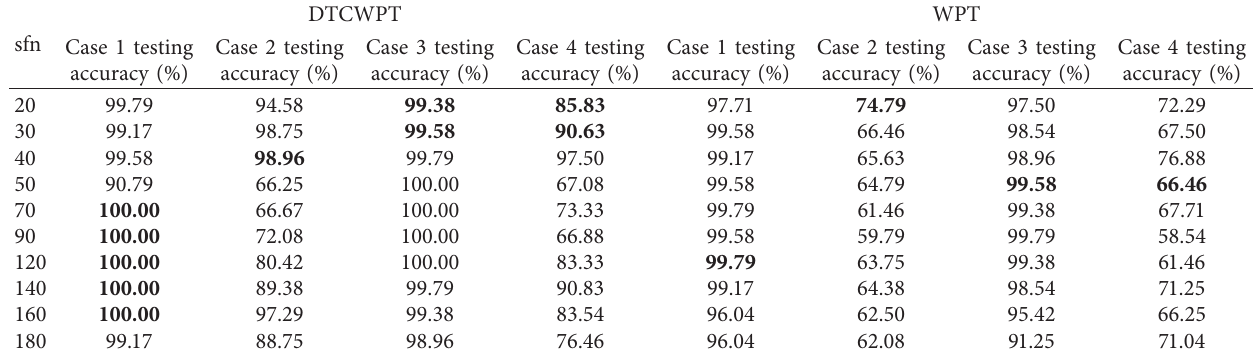
Table 14: Testing accuracies obtained by OFS-TSFRS-LFDA-SVM. DTCWPT WPT